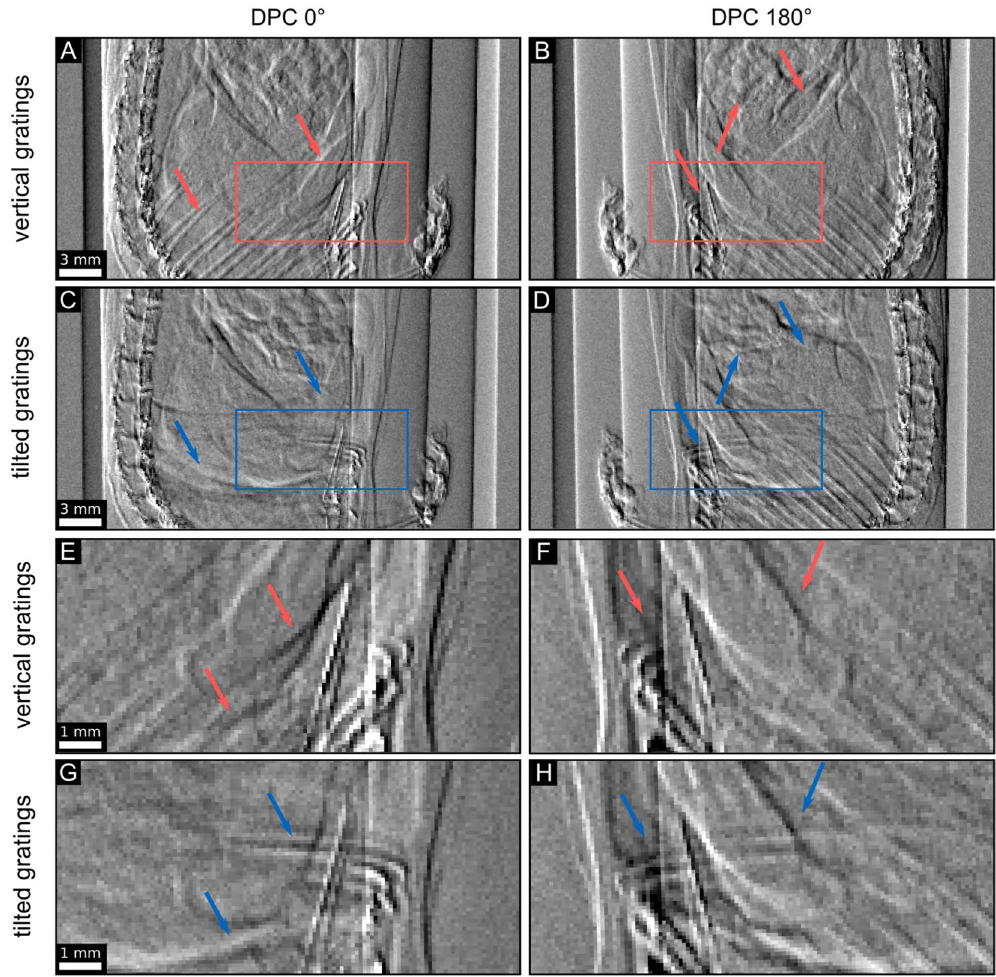
Figure 3. Comparison of non-tilted and tilted DPC projections. Exemplary DPC projections of a mouse sample are shown. The top row represents the measurement with vertical gratings and the second row the tilted grating configuration. Subfigures ( A ) and ( C ) depict the DPC signal of the mouse at rotation angle 0°, subfigures ( B ) and ( D ) represent the same sample at the opposing 180° sample position. The colored arrows mark conspicuous differences at the same rotational position like ribs or intestines. Subfigures ( E – H ) represent magnifications of the respective rectangles in subfigures ( A – D ). The scale of ϕ is linearly displayed in an interval of [ − 0.4,